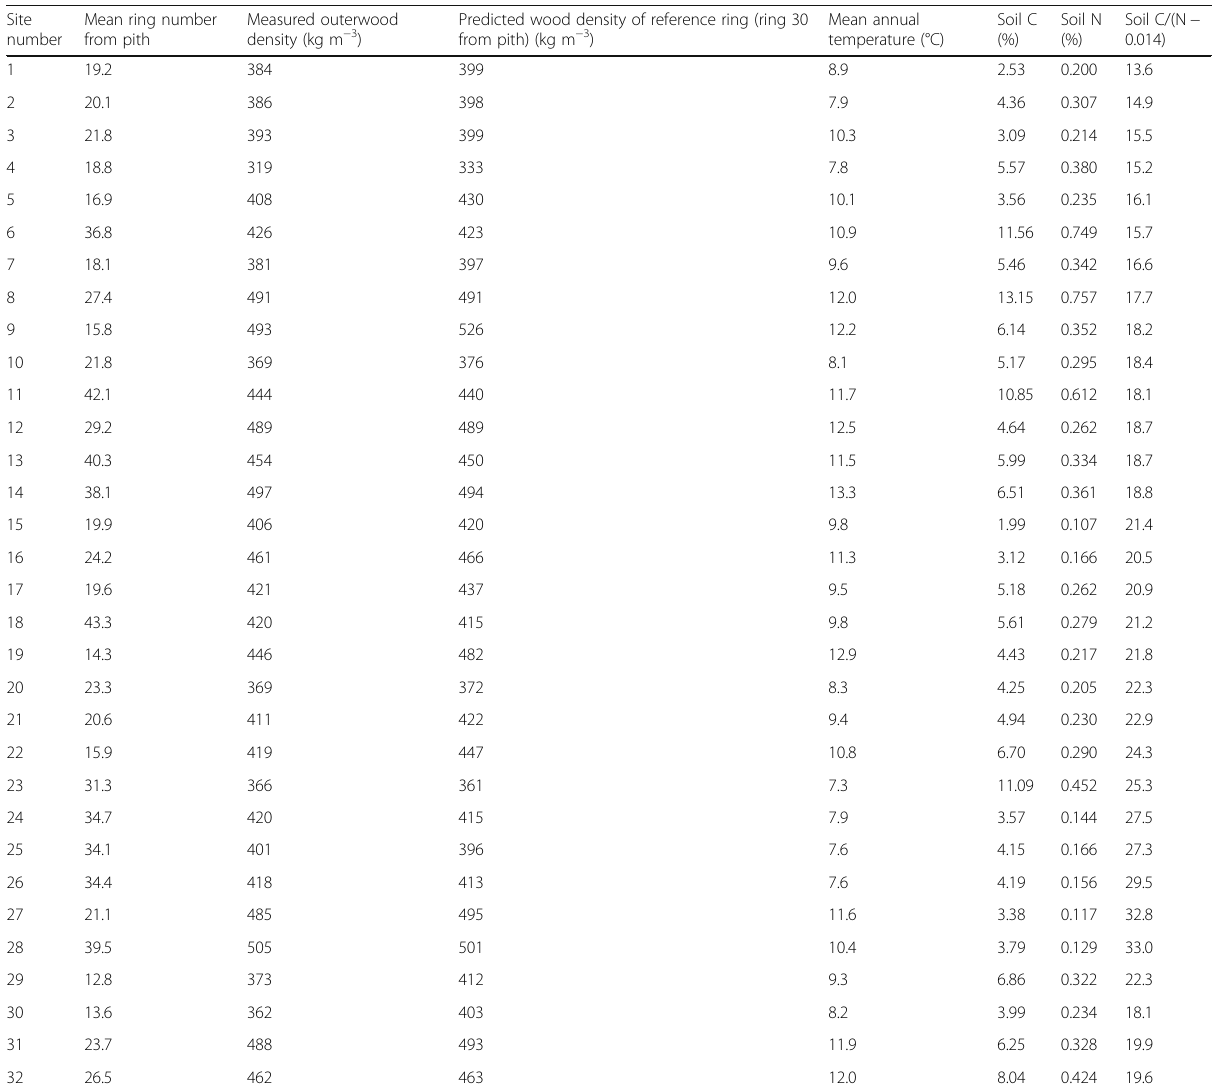
Table 2 Outerwood basic density of 50-mm core samples, mean ring number from pith, predicted basic density of ring 30 from pith, and environmental variables at 32 Douglas-fir sites used to develop sub-model 1 Site Mean ring number number from